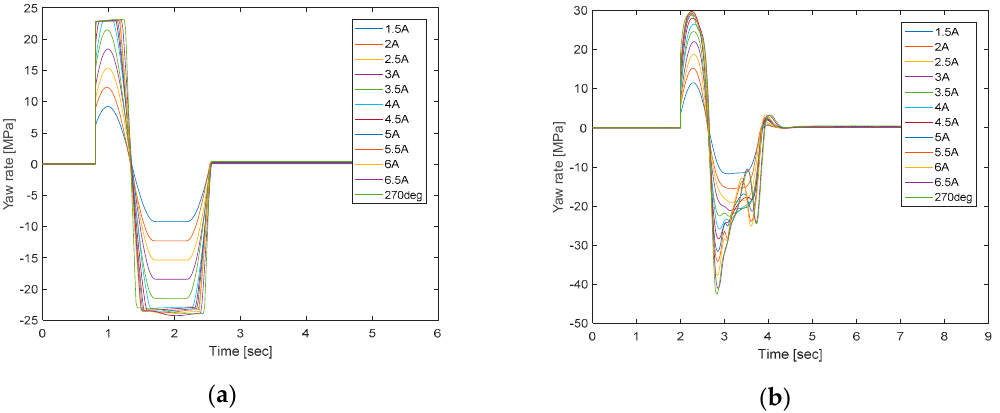
Figure 24. The yaw rate graphs of the vehicle model based on traditional PID control when 𝜇 = 0.5. ( a , b ) are the nominal yaw rate and actual yaw rate of the vehicle model using traditional PID control when the road adhesion coefficient is 0.5.